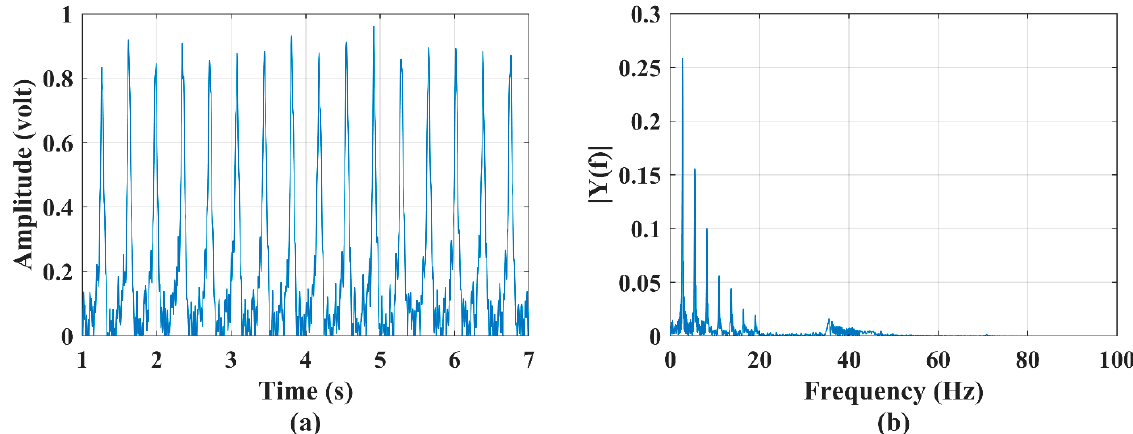
Figure 5. ( a ) Time − series plot and ( b ) power spectrum plot of a bionic bird’s sustained flapping action and a three − blade propeller system rotational motion.